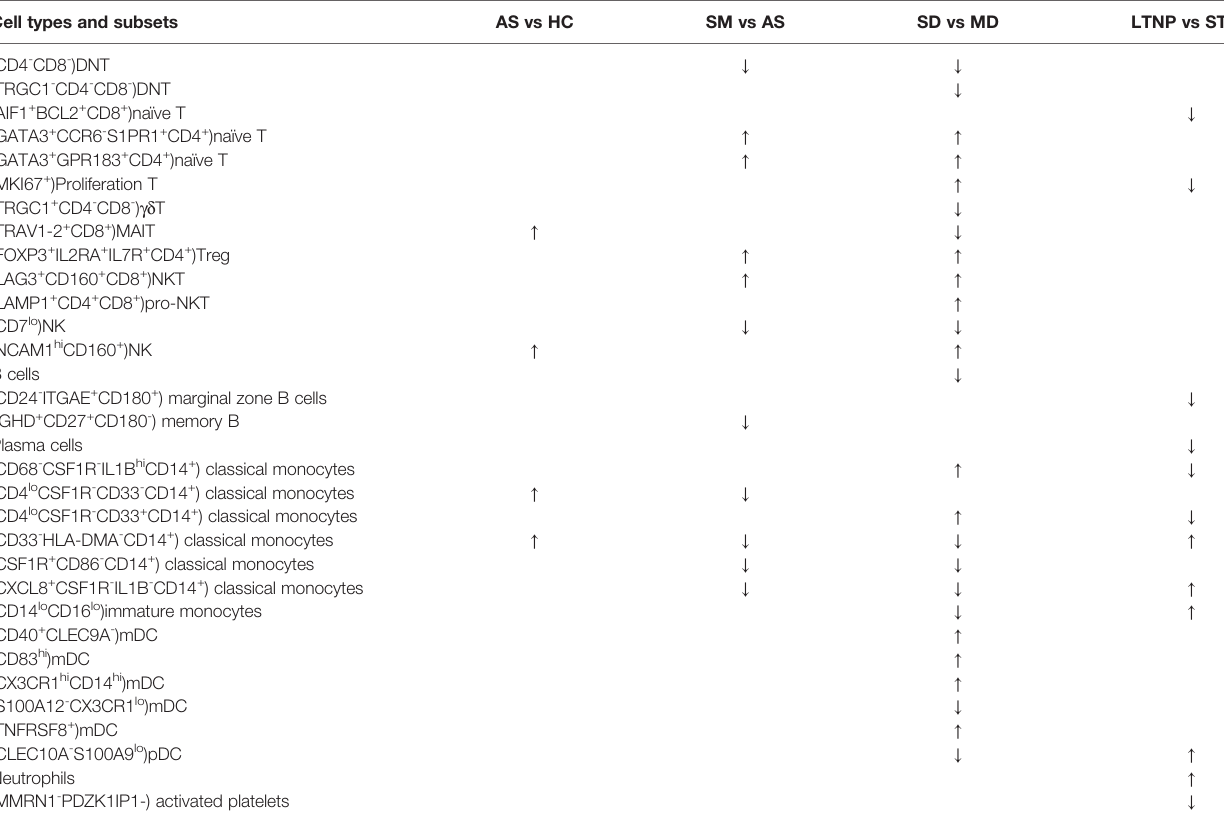
TABLE 1 | Distinct cell subsets associated with various clinical presentations of SARS-CoV-2 infection. Cell types and